Question: Looking at the figure, what chart type is it?
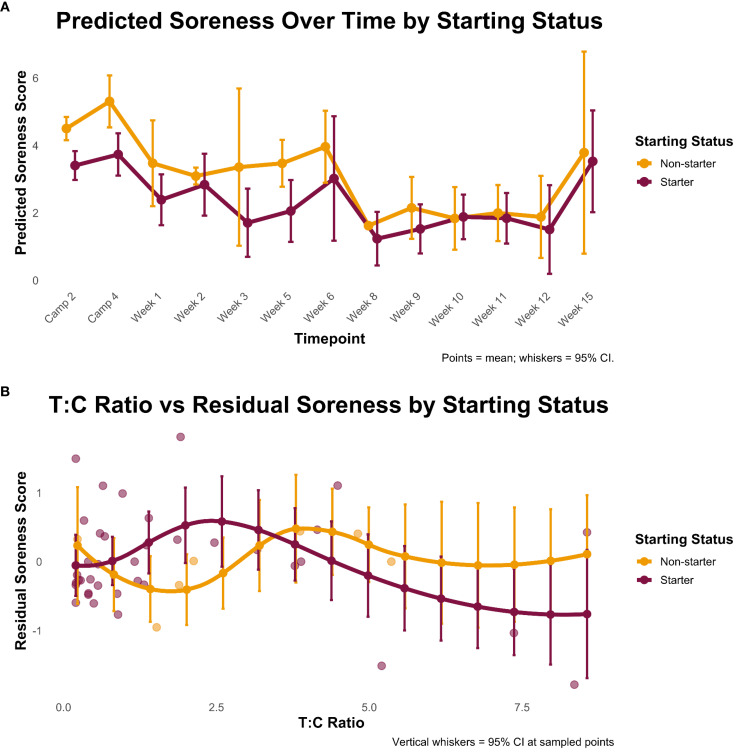
Answer: bar